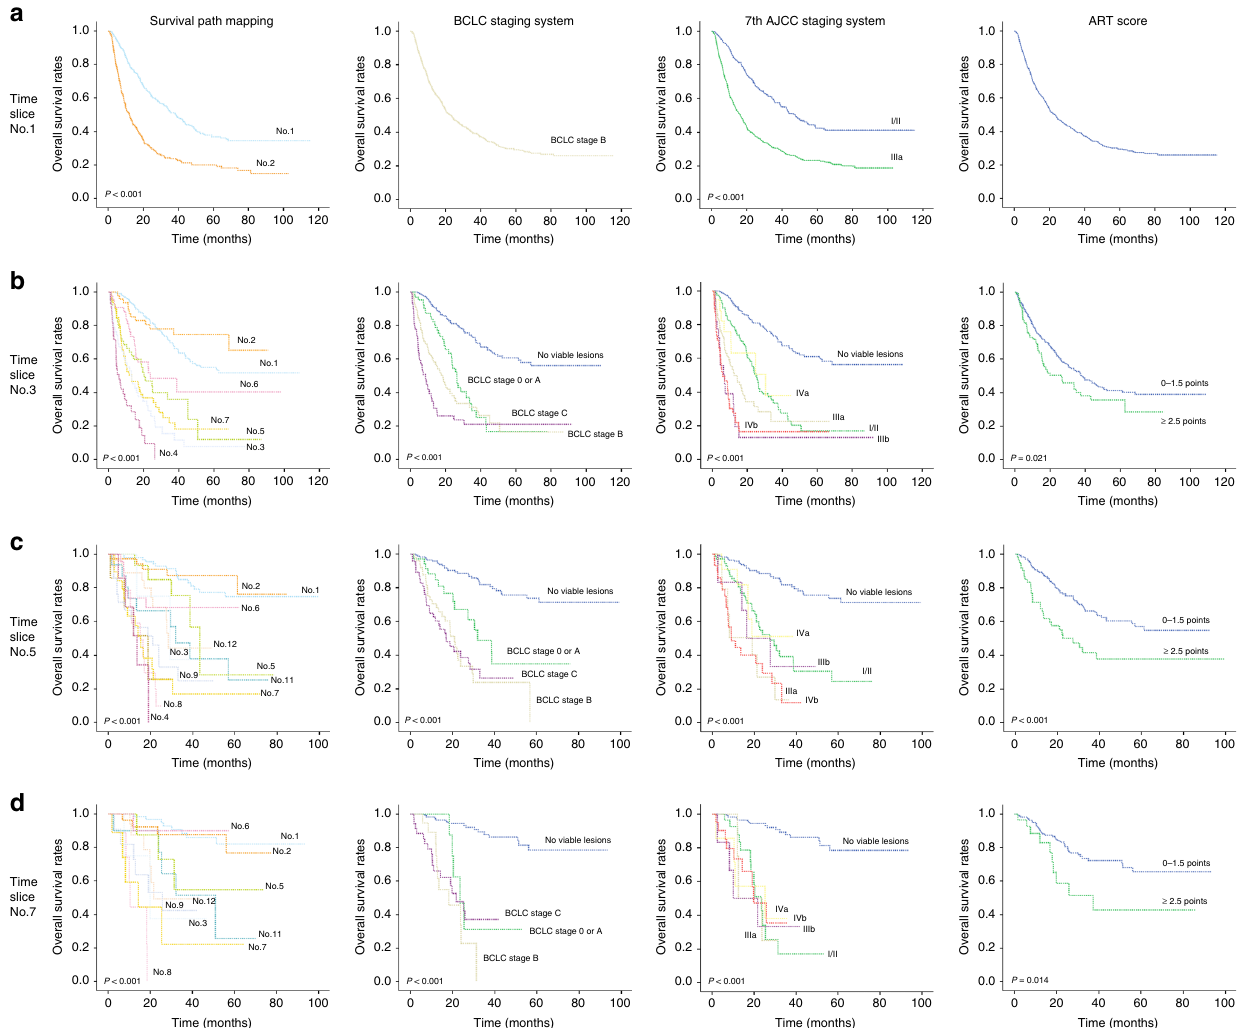
Fig. 2 Kaplan – Meier plots in the derivation cohort. Kaplan – Meier plots showed OS divided by the survival path system, BCLC staging system, AJCC staging system, and ART score, respectively, at time slice No.1 ( a ), time slice No.3 ( b ), time slice No.5 ( c ), and time slice No.7 ( d ) in the derivation